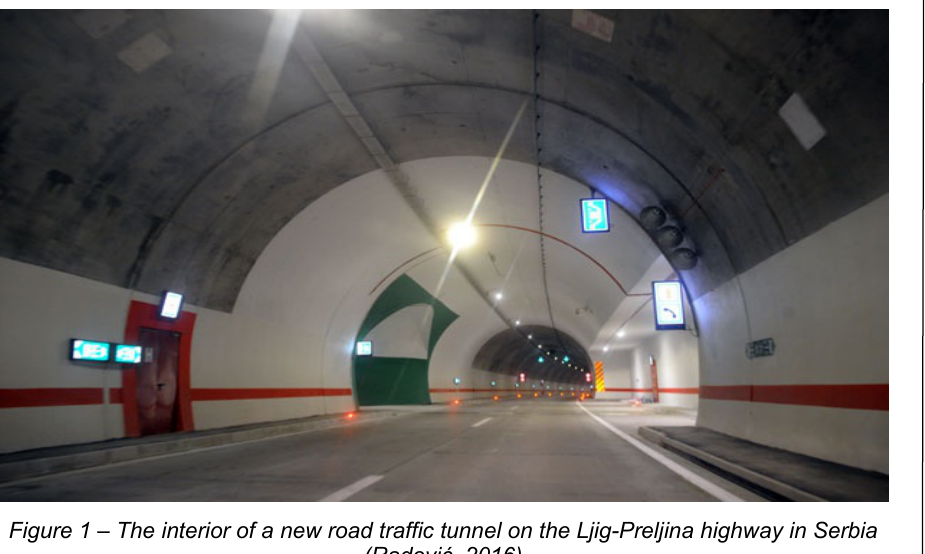
(Radovi ć , 2016) Рис . 1 – Внутреннее обустройство тоннеля на автомагистрали Лиг - Прелина в Сербии (Radovi ć ,